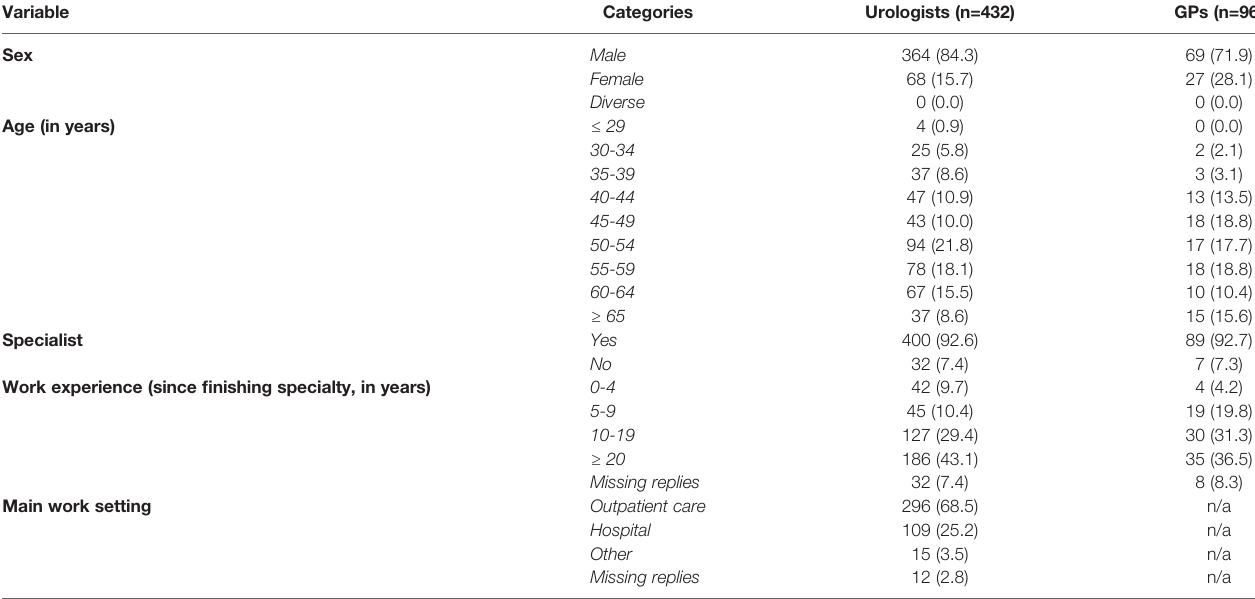
TABLE 1 | Characteristics of urologists and general practitioners [n